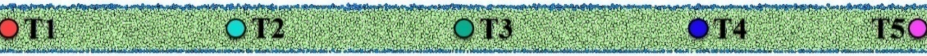
Figure 2. A strip PDEM model of the foundation and measuring points.